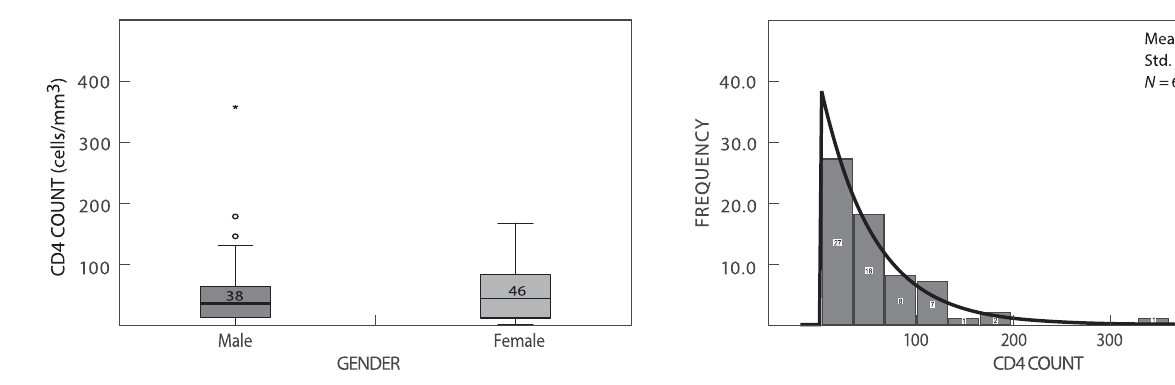
Figure 1: Box diagram of the CD4 count distribution of male and female patients admitted to PMMH with con fi rmed CCM.